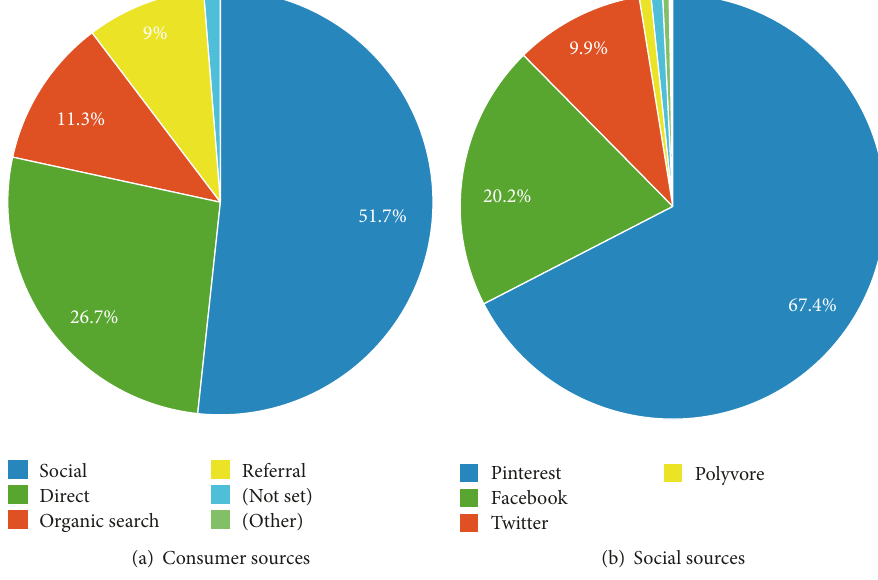
Figure 14: Traffic sources to the product collection